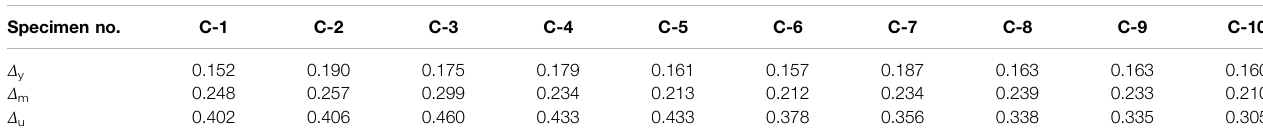
TABLE 7 | Measured h e at characteristic points. Specimen